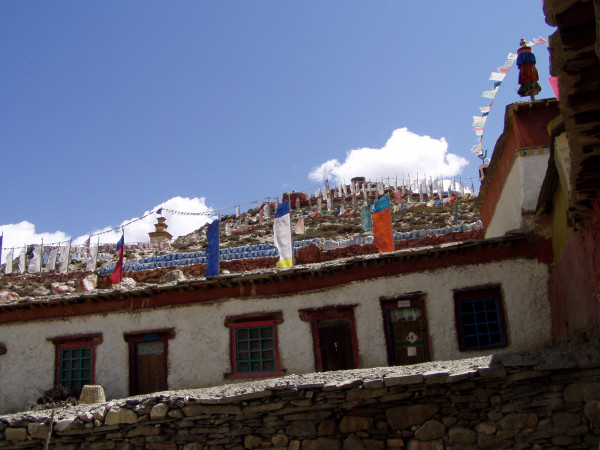
Monastery of Phoo